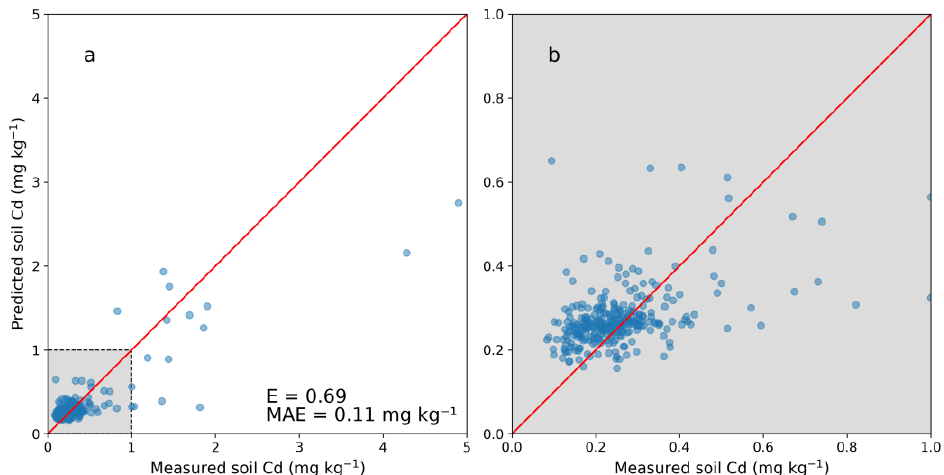
Figure 3. ( a ) Cross-validation of the digital soil mapping (DSM) model for predicting cadmium (Cd) concentrations from spatial covariates and ( b ) enlarged image of the range of 0–1 mg kg − 1 . Five folds were used on 304 samples with laboratory-analyzed Cd concentrations. The Nash–Sutcliffe model efficiency coefficient is displayed (E) as well as the mean absolute error (MAE).